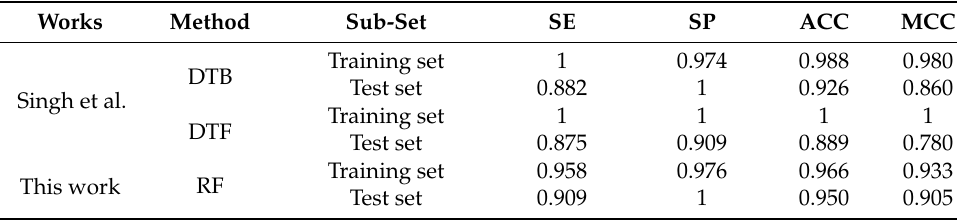
Table 2. Comparison of statistical parameters between present model and past models.